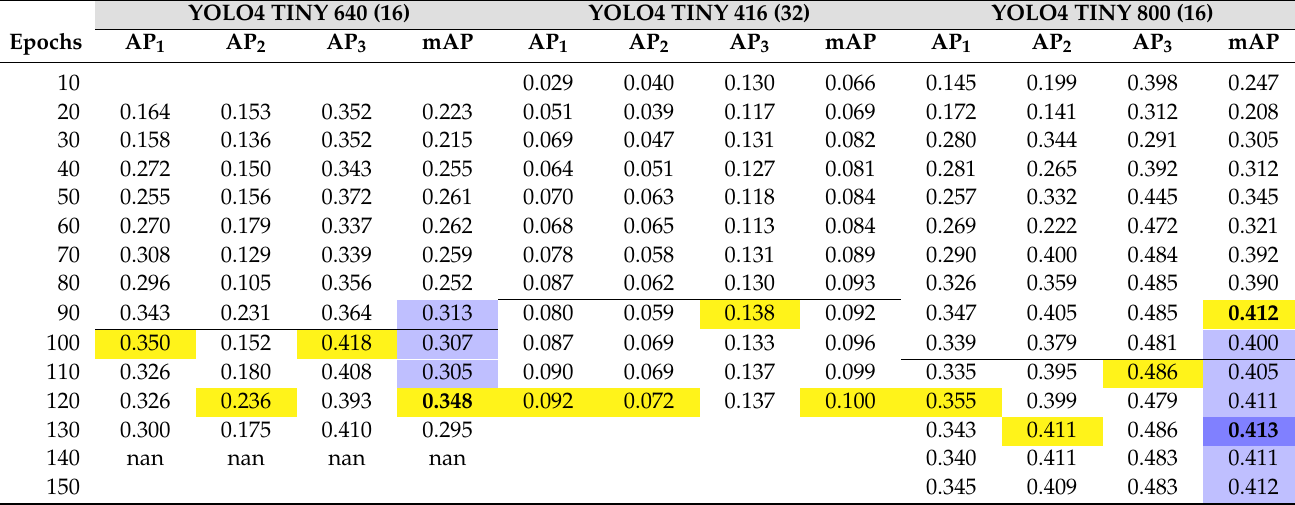
Table 3. YOLO4 experiments and